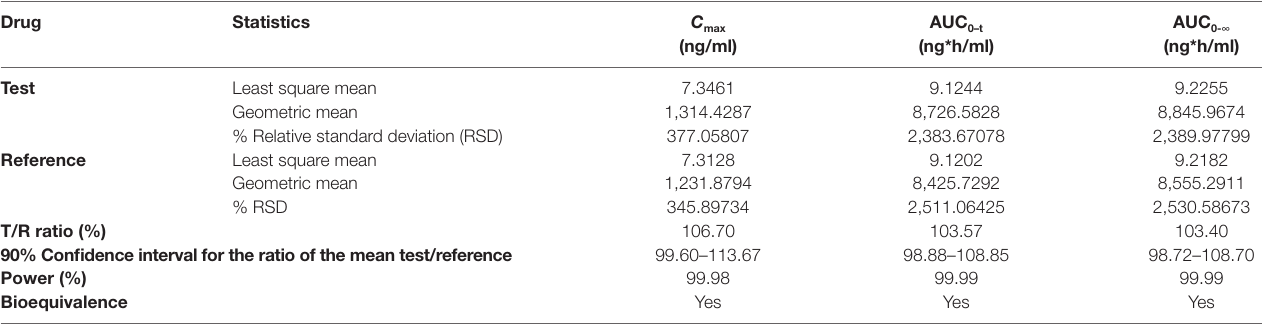
TABLE 7 | ANOVA analysis of primary pharmacokinetic parameters for OLM after oral administration of single dose of test and reference tablets in human subjects ( n =